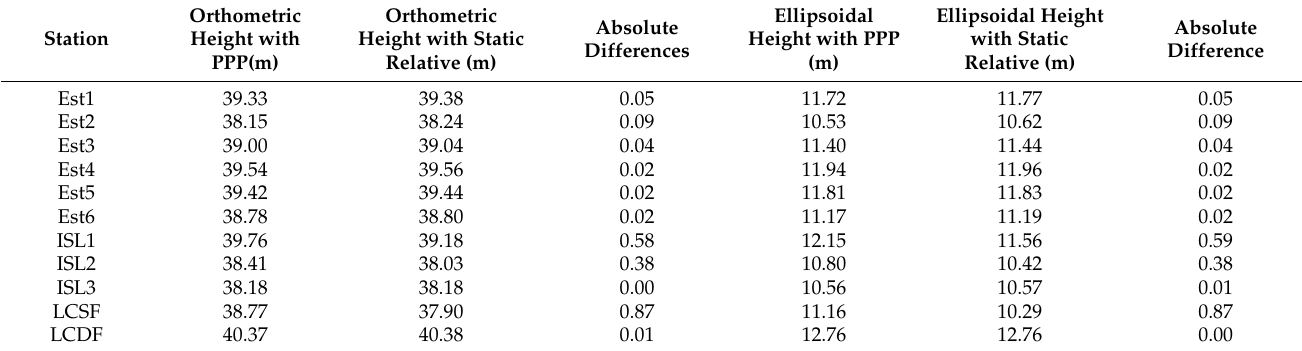
Table 10. Heights obtained using the GGM10 model and the absolute